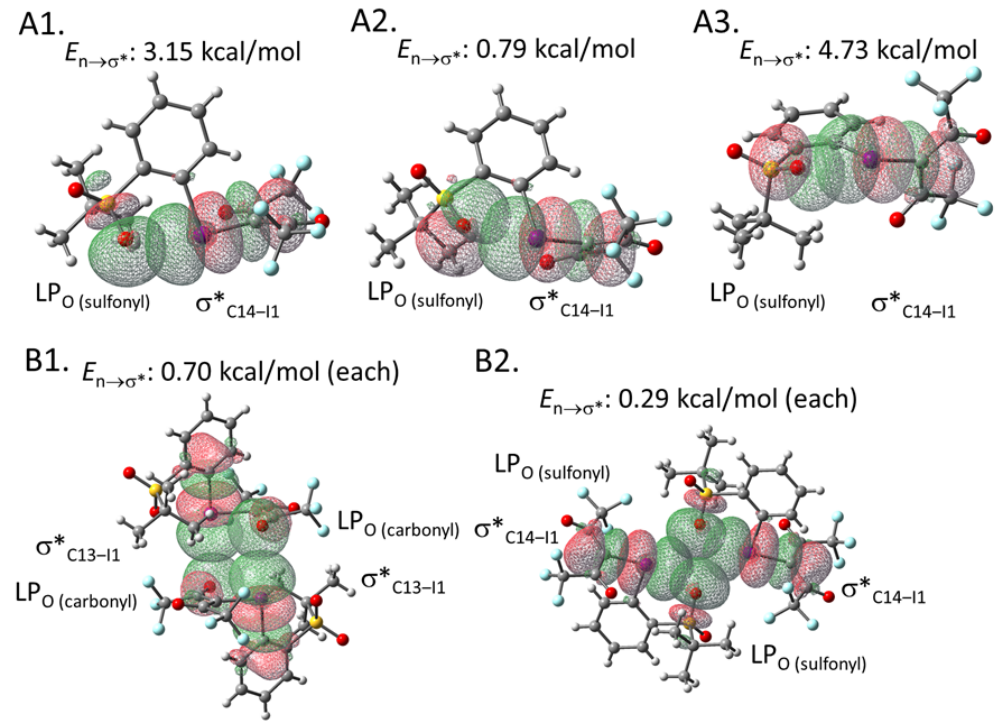
Figure 3. NBO analysis of iodonium ylide 2e . ( A1 ) Intramolecular XB between a lone pair of the sulfonyl group (Orbital#71) and the C14-I1 σ * orbital (Orbital#136) (type 1). ( A2 ) Intramolecular XB between a lone pair of the sulfonyl group (Orbital#120) and the C14-I1 σ * orbital (Orbital#136) (type 2). ( A3 ) Intramolecular XB between a lone pair of the sulfonyl group (Orbital#119) and the C14-I1 σ * orbital (type 3) (Orbital#136). ( B1 ) Intermolecular XB between a lone pair of the carbonyl group and the C13-I1 σ * orbital. ( B2 ) Intermolecular XB between a lone pair of sulfonyl group and the C13-I1 σ *